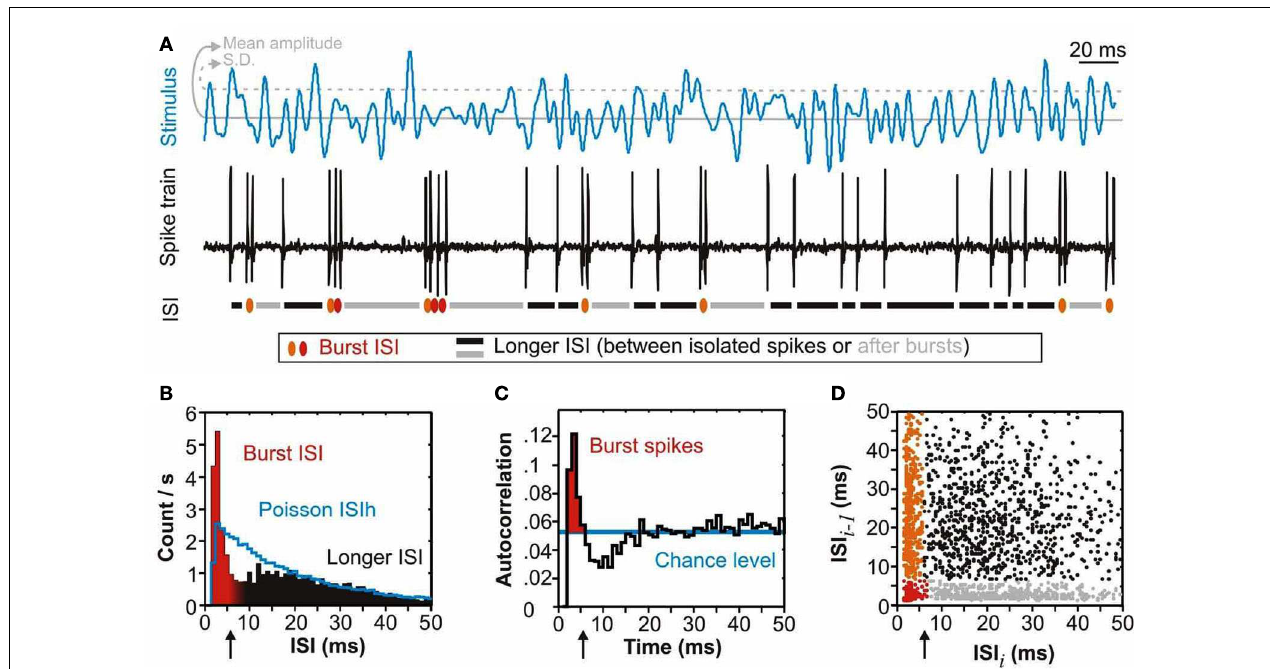
linear transformation would transform a Gaussian input into a Poisson point process.The ISIh of a model Poisson neuron with identical mean firing rate and refractory period is shown in blue. (C) Autocorrelation function.The autocorrelation function gives the probability of having a spike at different time intervals following each spike in the response. A random process would lead to a probability per bin of (Firing rate) × (bin width), in this case 52Hz × 0.001s, for all intervals (blue line).The peak at short intervals (red) quantifies the higher-than-chance probability of having spikes separated by short intervals in bursting neurons. (D) ISI return map.The return map plots the ISI that precedes each spike as a function of the ISI that follows it. Several clusters can be observed: a cluster along the y -axis consisting of the first ISIs of each burst (orange), in the bottom left corner the subsequent intra-burst ISIs (red), a cluster along the x -axis for the ISIs that follow bursts (gray) and a more scattered cluster at longer intervals for ISIs between isolated spikes (black).The ISI return map is a way of visually characterizing the spike-train structure and revealing the bursting tendency of the neuron, as non-bursting neurons will not display clusters along the axes at short